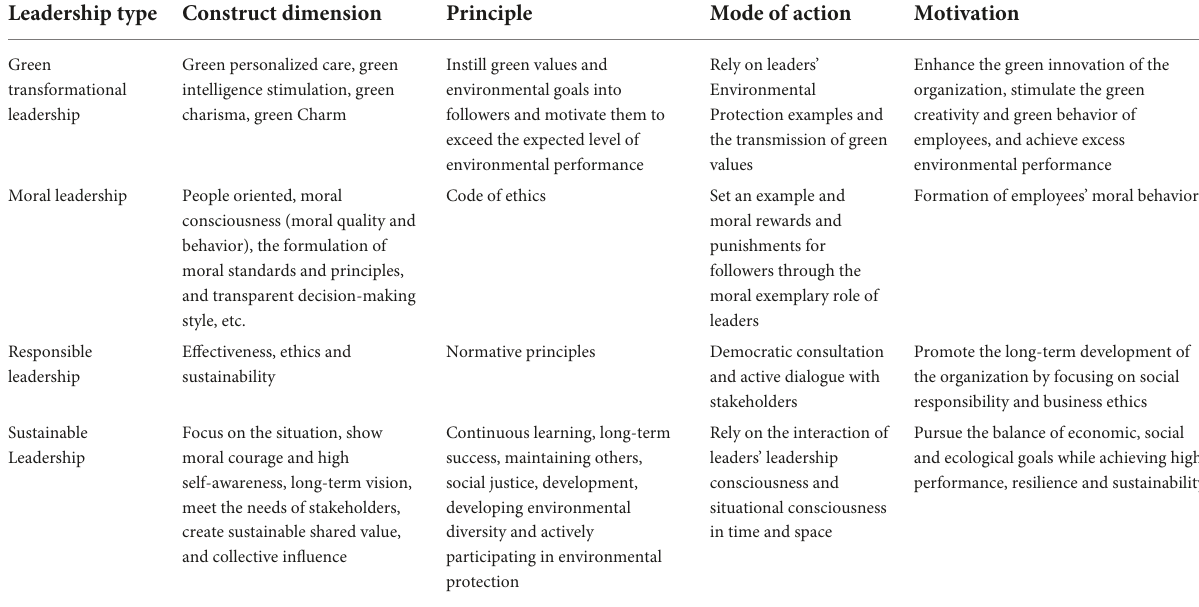
TABLE 2 The comparison of leadership